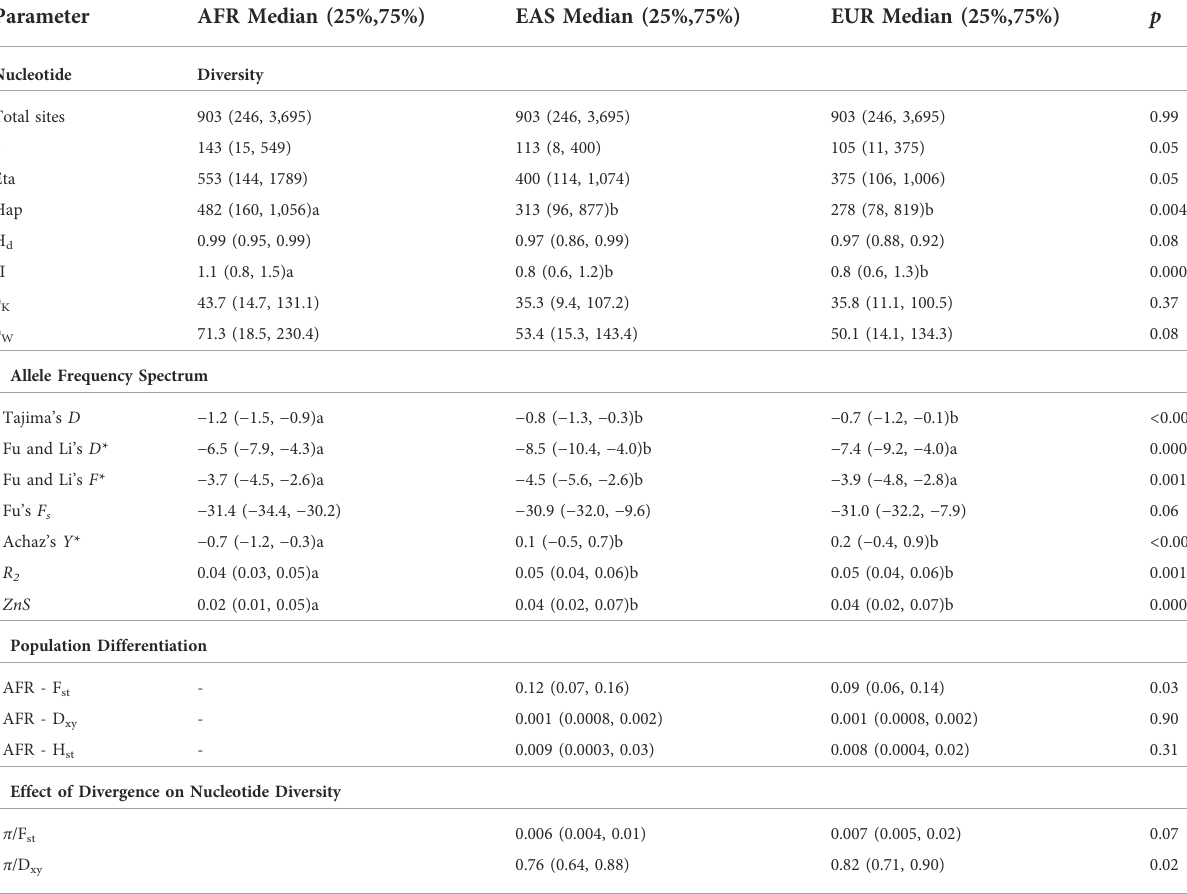
TABLE 2 Comparison of population genetic parameter estimates of 114 BD associated genes among 1,000 Genomes African (AFR), East Asian (EAS), and European (EUR) populations.